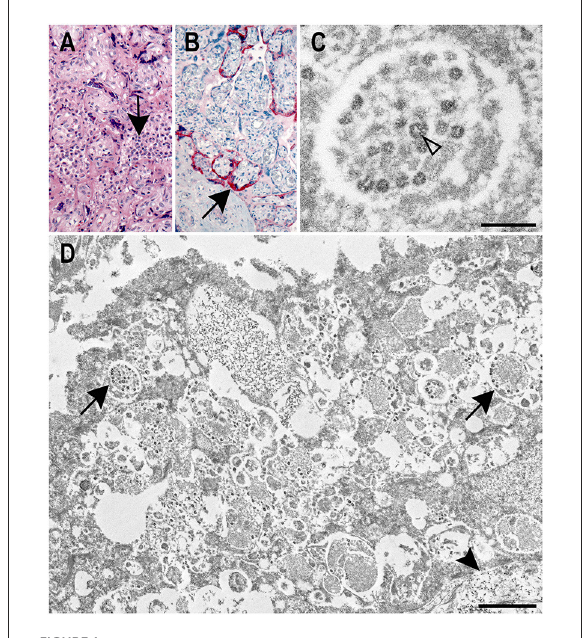
FIGURE1 Correlative histology, immunohistochemistry, and ultrastructural findings in a SARS-CoV-2 positive placenta. (A) Placenta showing histiocytic intervillositis (arrow) with villous trophoblast necrosis and fibrin (H&E, original magnification 20X). (B) Immunostaining of SARS-CoV-2 nucleocapsid protein (arrow) in the syncytiotrophoblast of the placenta (IHC, original magnification 20X). (C) Electron microscopy image displaying a membrane bound accumulation of coronavirus particles in the syncytiotrophoblast. Cross sections through the viral nucleocapsid visible (open arrowhead). Scale bar: 200nm. (D) Vacuolar, membrane bound accumulations of coronavirus particles (arrows) in the syncytiotrophoblast of the placenta as seen by electron microscopy. A cytotrophoblast (arrowhead) is visible below the syncytiotrophoblast. Scale bar: 1 µ